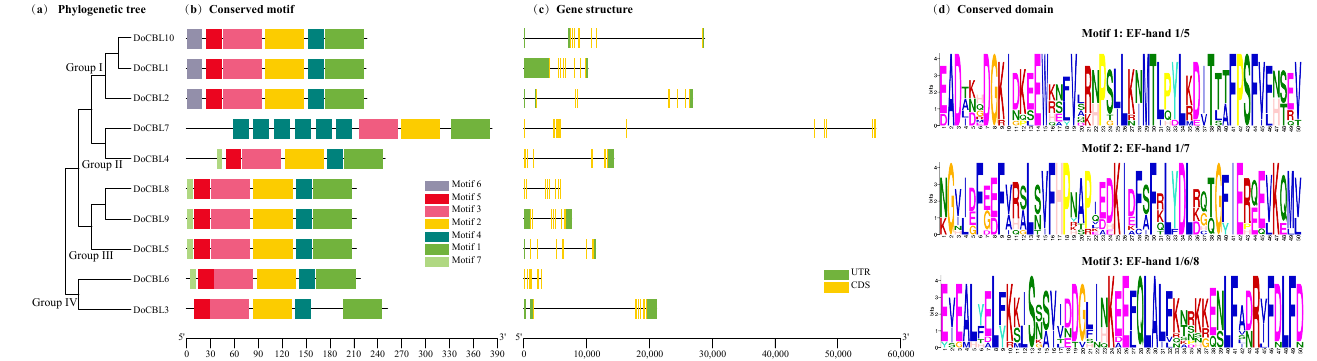
Figure 4. Phylogenetic tree of DoCBL proteins ( a ), motif distribution ( b ), gene structure ( c ) and conserved domains and motifs ( d